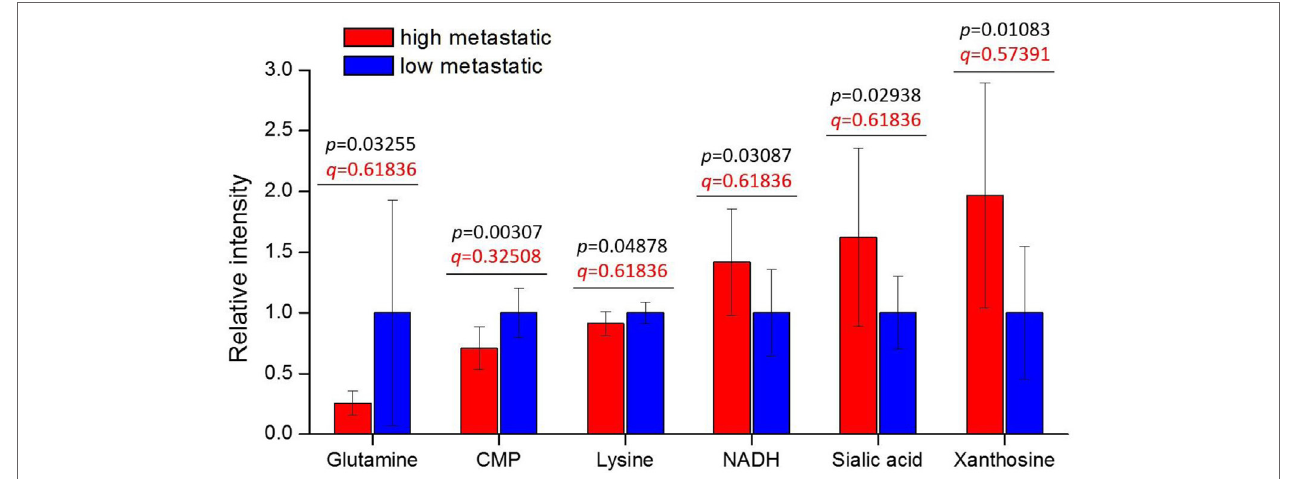
FigUre 1 | Tumor metabolite levels are significantly different between high- and low-metastatic groups. The highly metastatic group comprises tumors from BL10 and CAST mice, while low-metastatic group comprises tumors from BL6 and MOLF mice. Prior to sorting into high- and low-metastatic groups, each matched pair was separately scaled to the average of low-metastatic samples: {BL10, BL6} scaled to the BL6 average, {CAST, MOLF} scaled to the MOLF average. Metabolite levels are represented relative to low-metastatic group average. Values are the average of 10 individual mouse tumors (5 of each background, 2 backgrounds per group). Error bars represent SD. Student’s t -test p -values are shown in black, and false discovery rate q -values are shown in